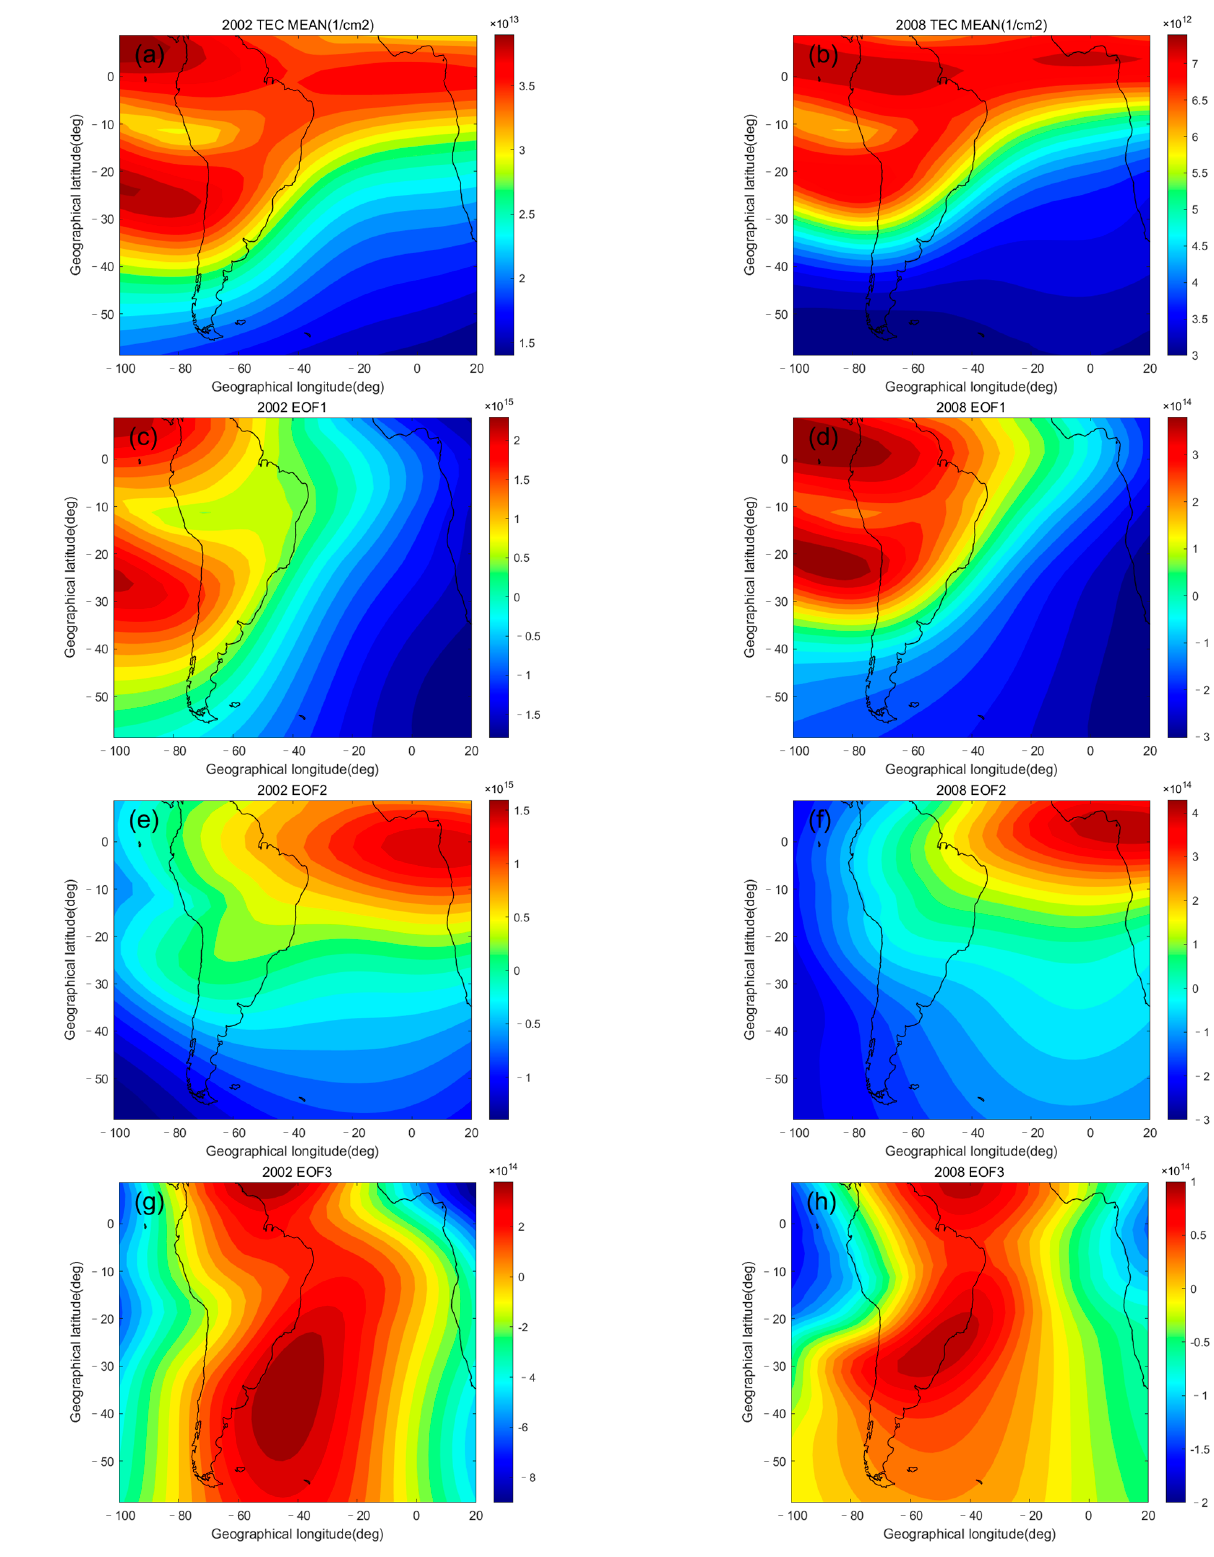
Figure 2. ( a , b ) TEC time-averaged maps (1/cm 2 ) derived from the TIEGCM simulations, and ( c – h ) the fi rst three EOF i (i = 1, 2, 3) in the SAA in each of 2002 and 2008.